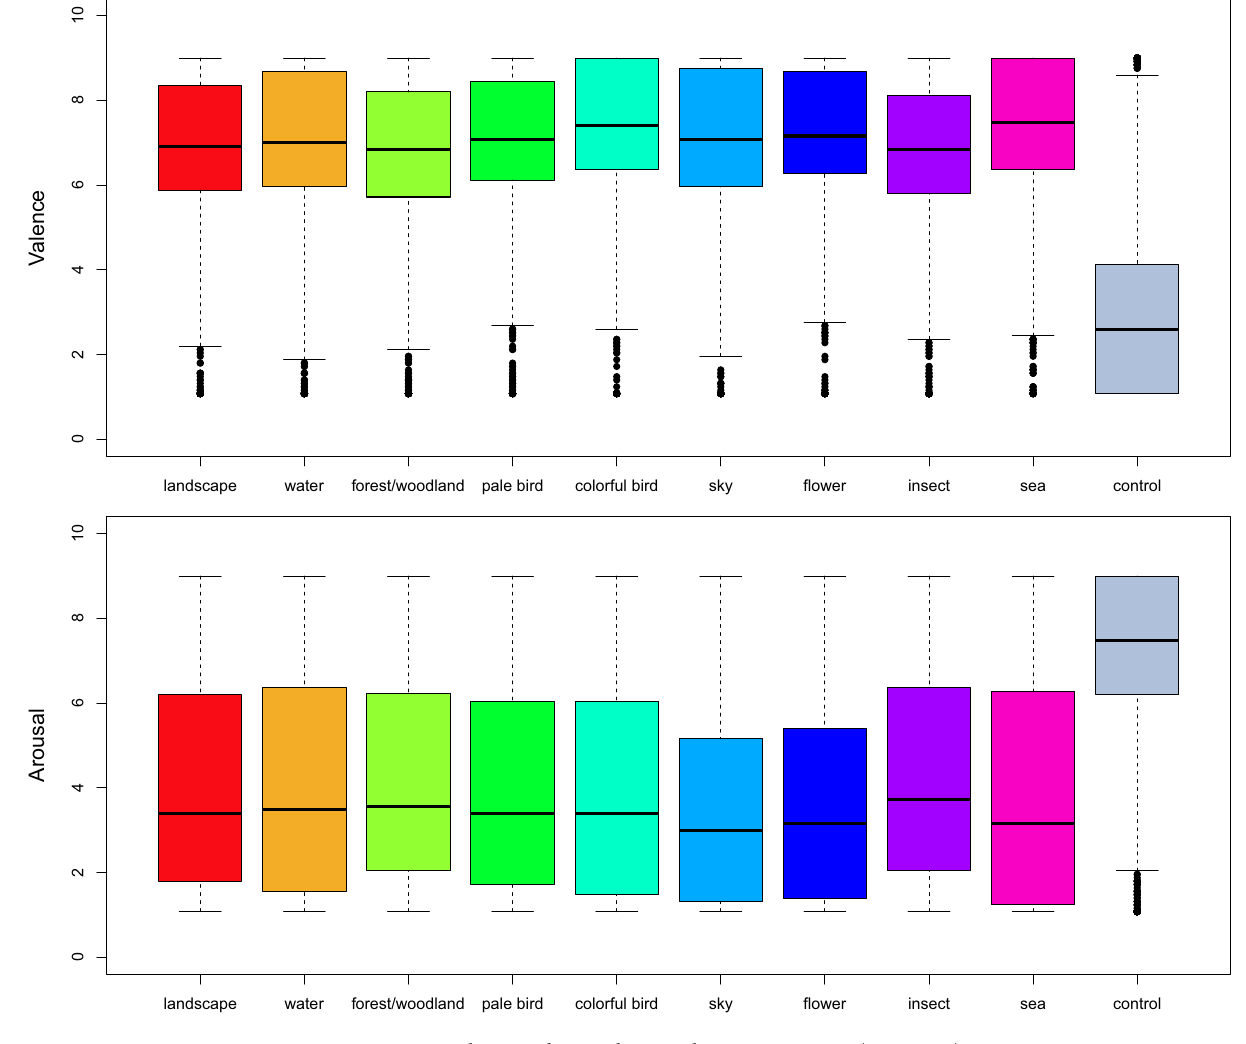
Figure 2. e-NatPOEM valence and arousal ratings by image category (n =